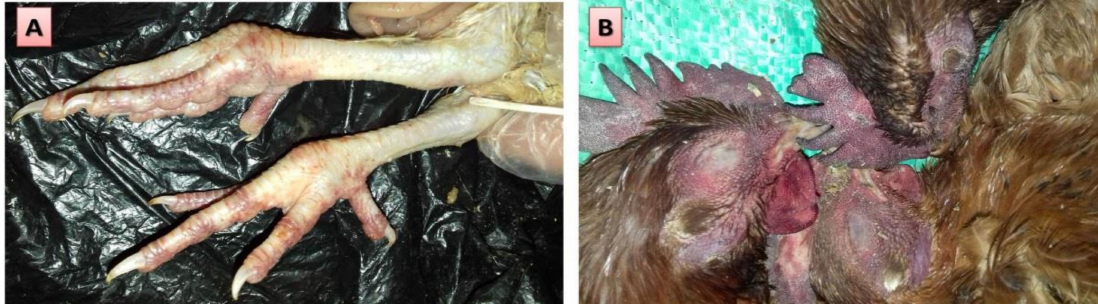
Figure 1. Clinical signs of H5 Avian Influenza Virus (AIV) in tested chickens. ( A ) Cyanosis of legs and ( B ) cyanosis of comb and